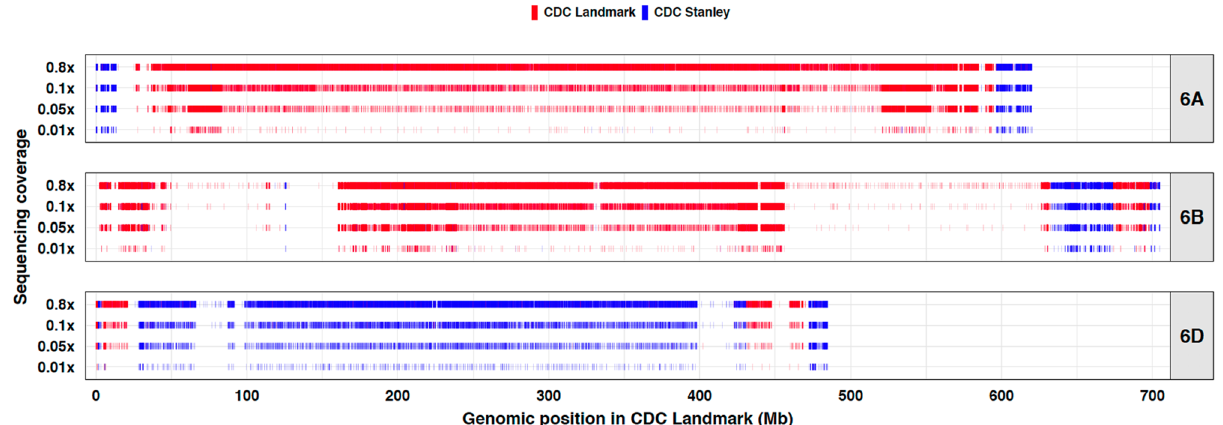
Figure 2. Genomic segments of CDC Landmark and CDC Stanley observed on chromosomes 6A, 6B and 6D of a doubled haploid line (DH01029-0) using various sequencing depths (original 0.8 × followed by simulated 0.1 ×, 0.05 ×, and 0.01 × from the original).